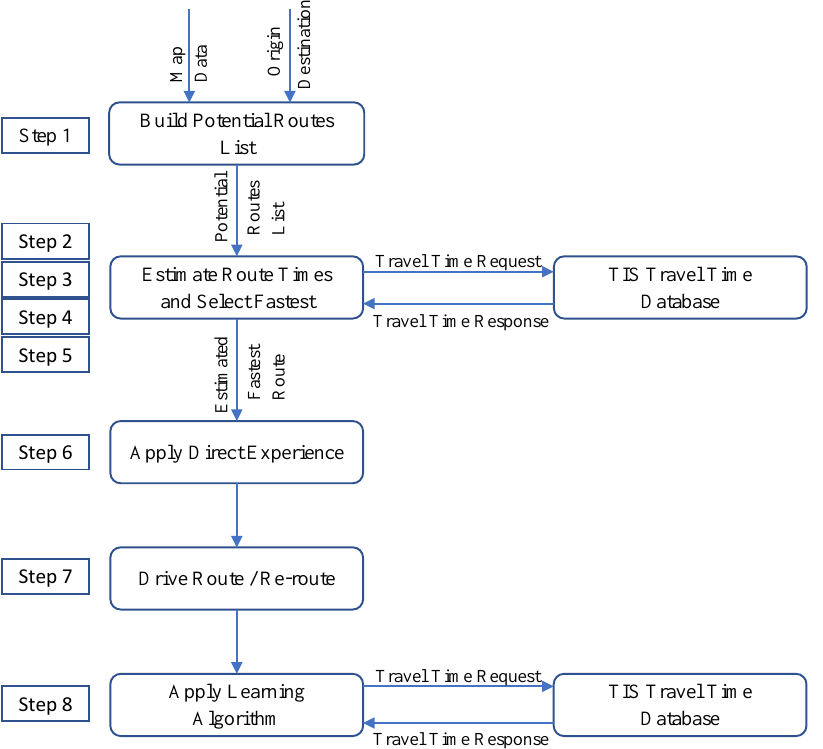
Figure 1. Agent routing